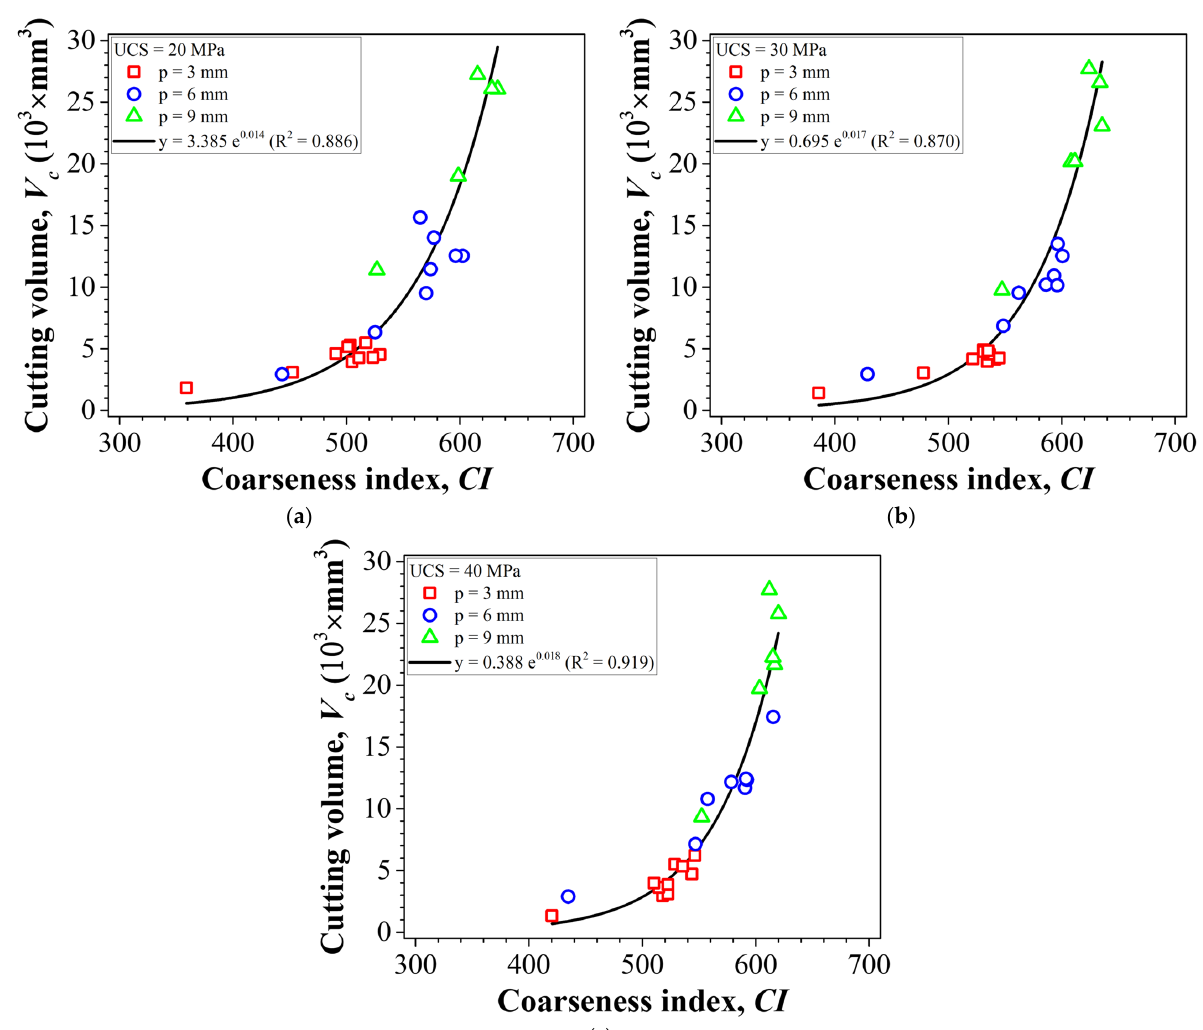
Figure 13. Relationship between CI and cutting volume: ( a ) rock of UCS 20 MPa; ( b ) rock of UCS 30 MPa; ( c ) rock of UCS 40 MPa.